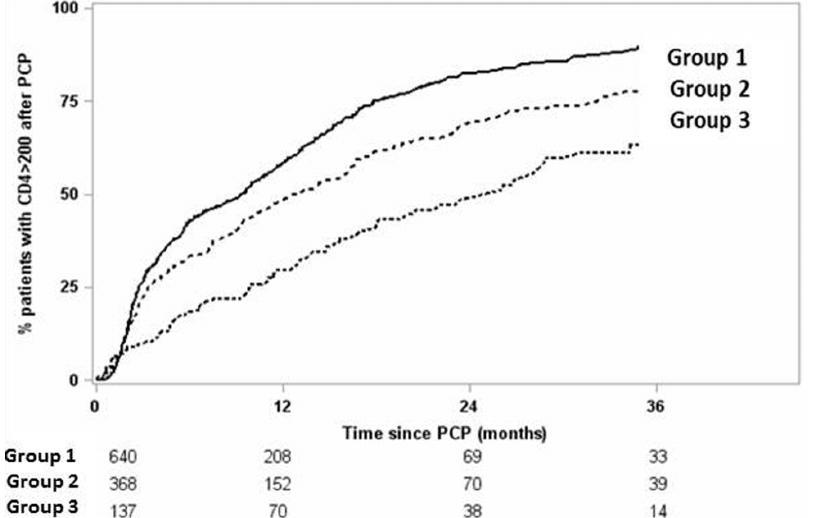
Figure 3. Kaplan-Meier estimates of immune reconstitution (CD4 cell count $ 200/mm 3 ) probability, and number of patients at risk, after PCP diagnosis for patients with an inaugural PCP revealing HIV infection (reference, group 1), previously enrolled patients with incident PCP without prior AIDS-defining clinical illness (ADI) (PE non-prior ADI, group 2) and previously enrolled patients with incident PCP with prior ADI (PE prior ADI, group3).